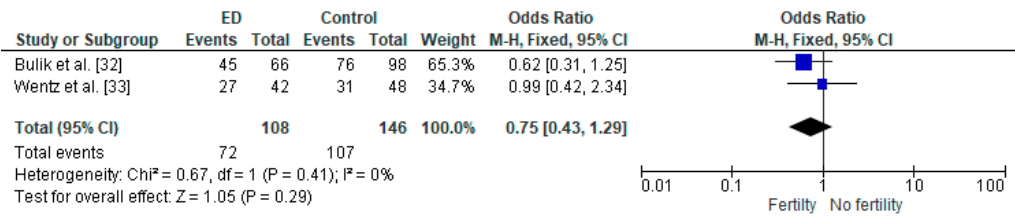
Figure 2. Forest plot of odds of childbirth rates in females with AN compared to controls.